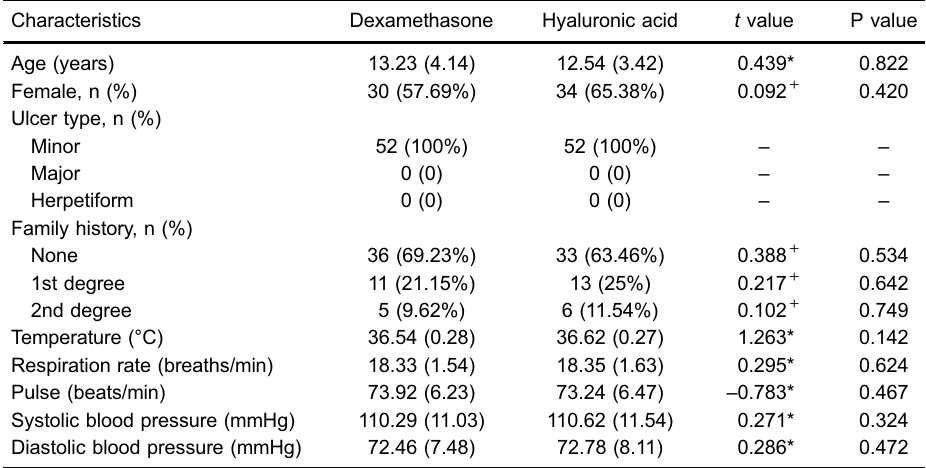
Table 1. Clinical and demographic characteristics of children with recurrent aphthous ulcers treated with dexamethasone or hyaluronic acid.